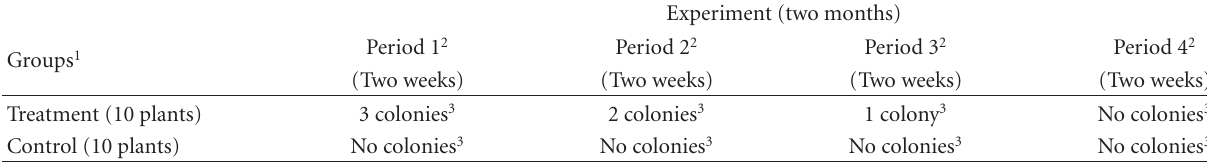
Table 1: Scheme represented the sampling design of the experiment.